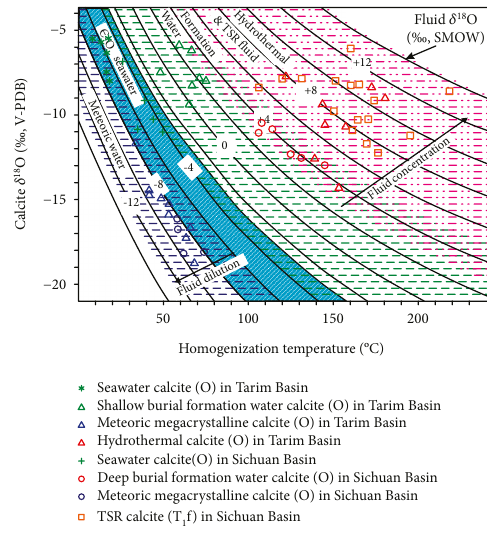
Figure 7: Relationships between oxygen isotopes of fl uid, oxygen isotopes of calcite, and homogenization temperatures of fl uid inclusions in